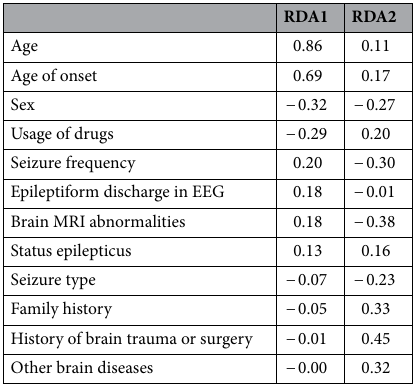
Table 6. The contribution of features in the RDA model.